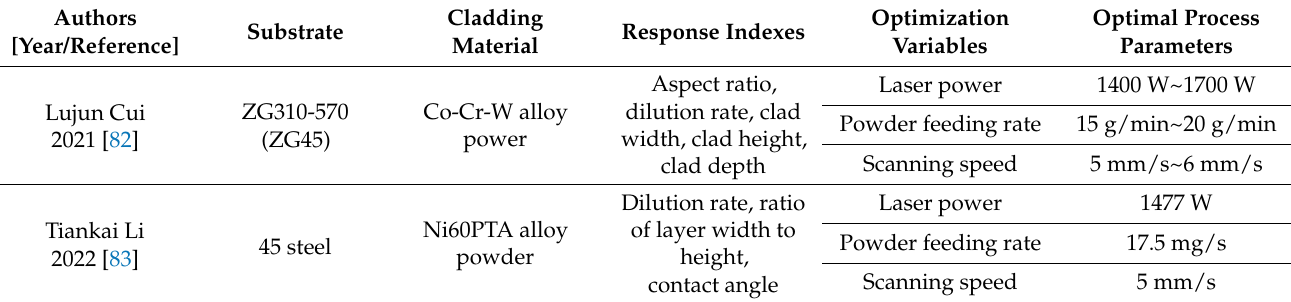
Table 2. Optimization variables and response indexes used in the response surface